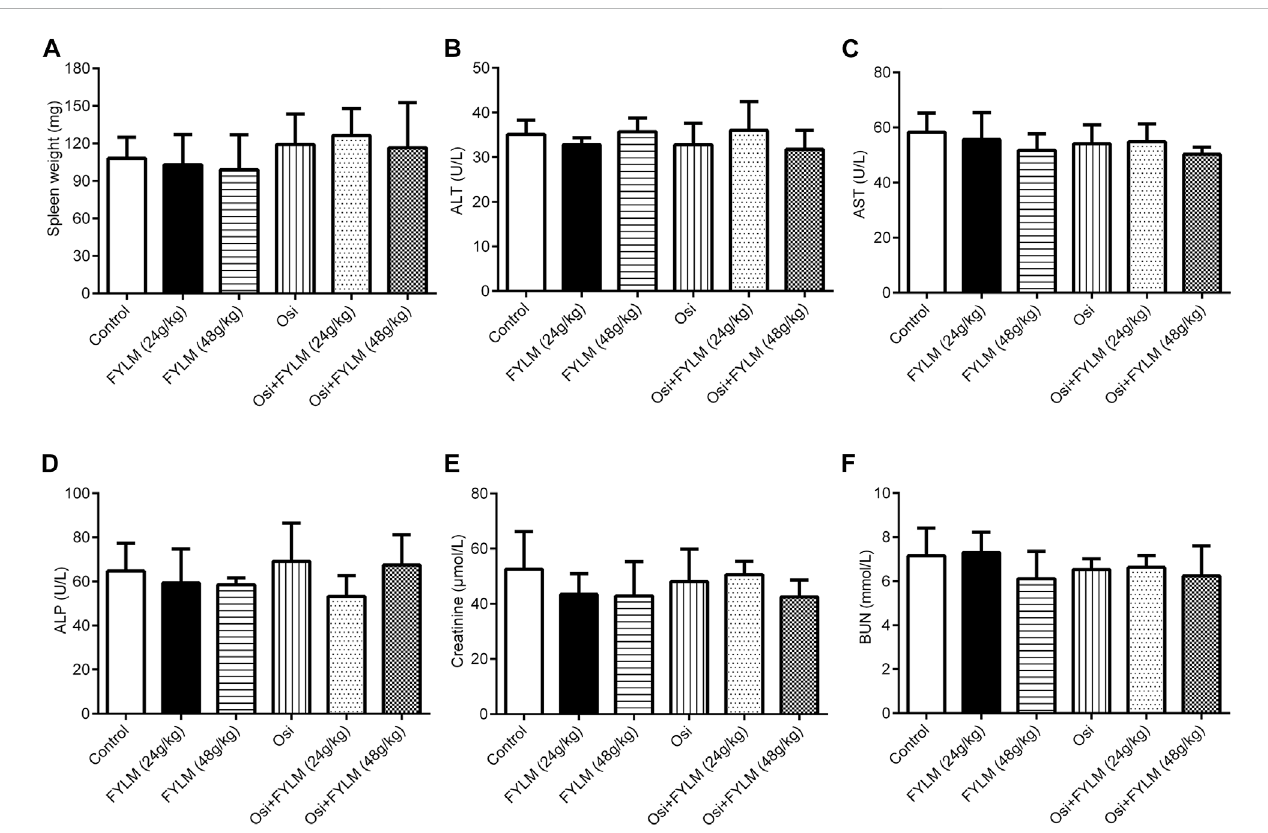
FIGURE 4 FYLM combined with osimertinib has no obvious toxicity to EGFR-Del19/T790M/C797S LLC tumor-bearing mice. (A) Spleen weight. (B) Alanine aminotransferase (ALT), (C) aspartate aminotransferase (AST), (D) alkaline phosphatase (ALP), (E) creatinine and (F) blood urea nitrogen (BUN) levels were measured after 2 weeks of drugs treatment. Osi, osimertinib. All data are shown as mean ±